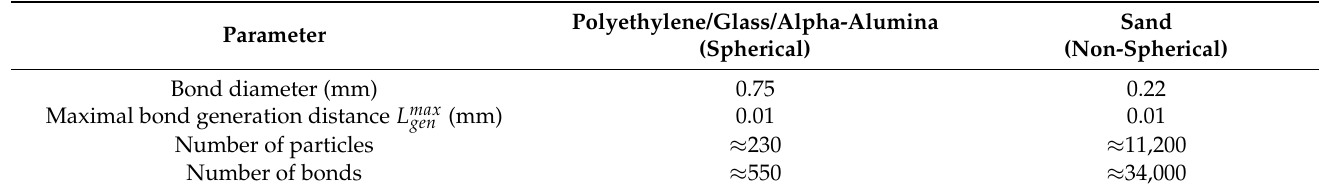
Table 5. Agglomerates bond generation set up for different types of PFS in 75% saturation level.